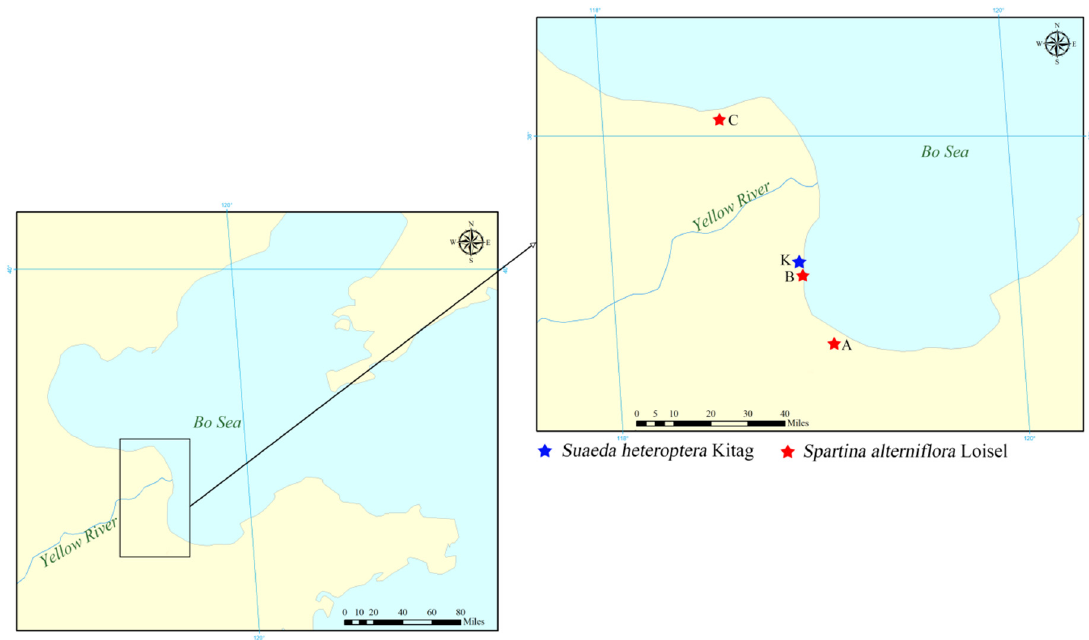
Figure 1. Sampling zones in the Yellow River Delta.